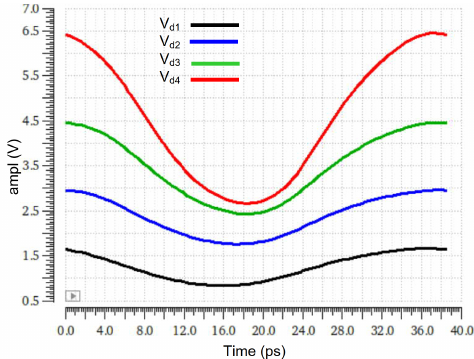
Figure 2. Simulated voltage swings at the drain nodes of M 1,2,3,4